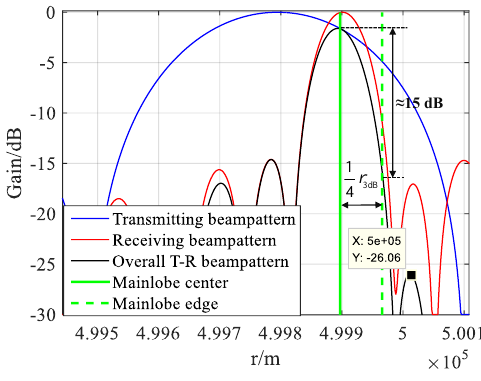
Figure 7. The overall T-R beampattern with intra-pulse beam scanning.